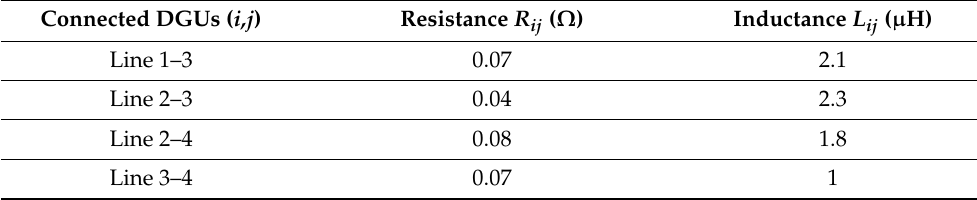
Table 1. Line parameters.